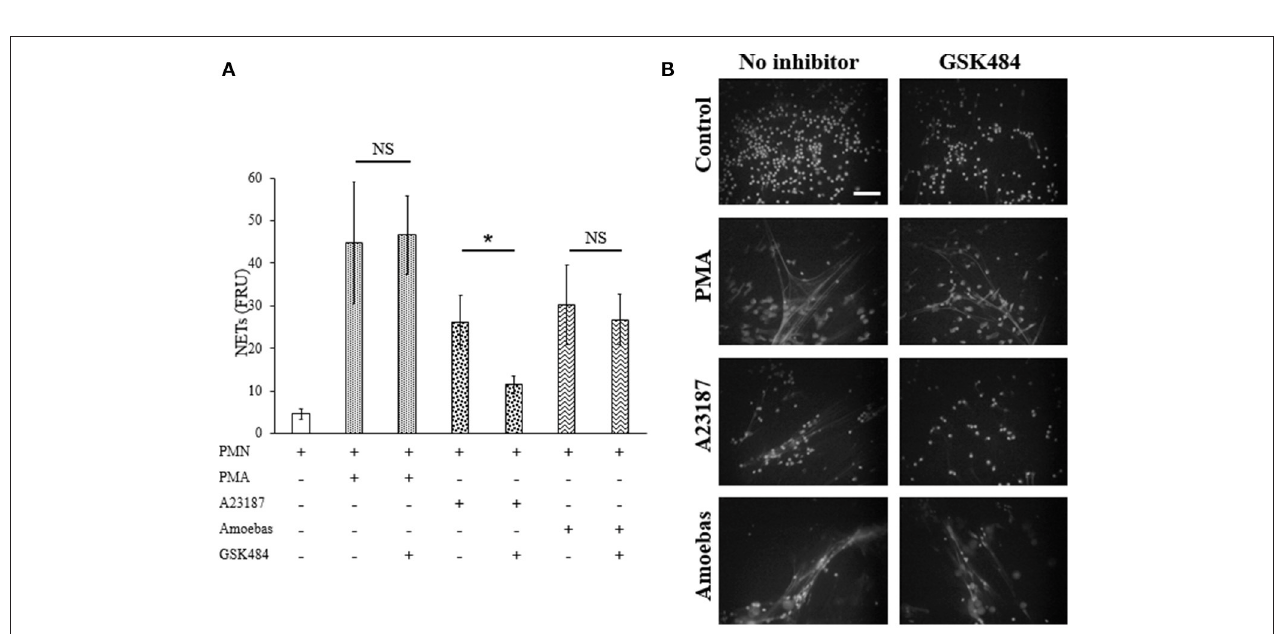
FIGURE 12 | NETosis induced by E. histolytica trophozoites is independent of PAD4 activity. (A) Neutrophils (3 × 10 5 ) were pre-incubated with 10 µ M GSK484 or DMSO for 30min and then stimulated with 20nM PMA, 10 µ M A23187, or co-cultured with trophozoites (1.5 × 10 4 ) during 4h. Supernatants were collected, mixed 1:1 with SYTOX Green (500nM) and fluorescence was measured. NETs amount is expressed in fluorescence relative units (FRU). Values are means ± SD of three independent experiments in triplicate. * p < 0.001. NS: statistically non-significant. (B) Neutrophils were treated as describe previously, fixed and stained with DAPI. Images were taken at 60x magnification. Scale bar 50 µ